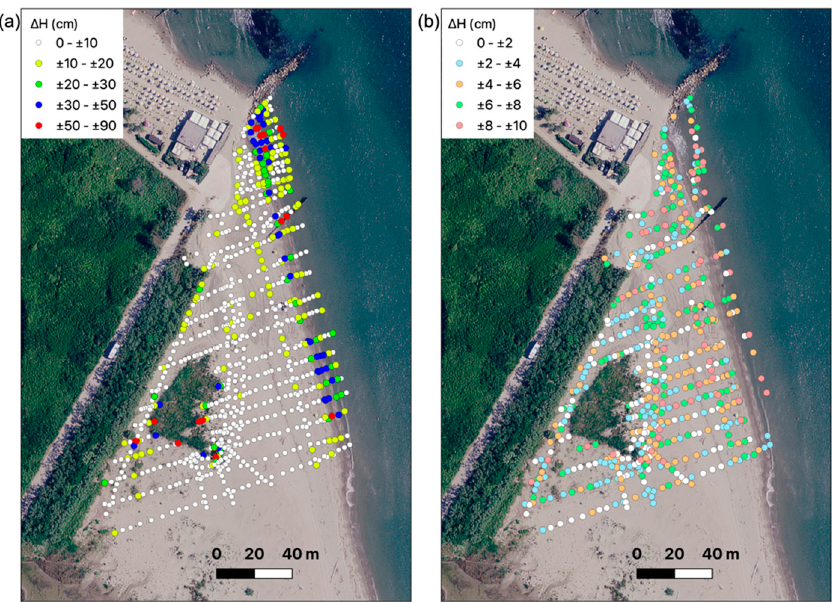
Figure 5. GNSS-acquired points and related height differences between RTK and photogrammetric UAV surveys for the 2020 campaign. ( a ) relates to all the values emphasizing the higher discrepancies; ( b ) relates to differences within 10 cm.